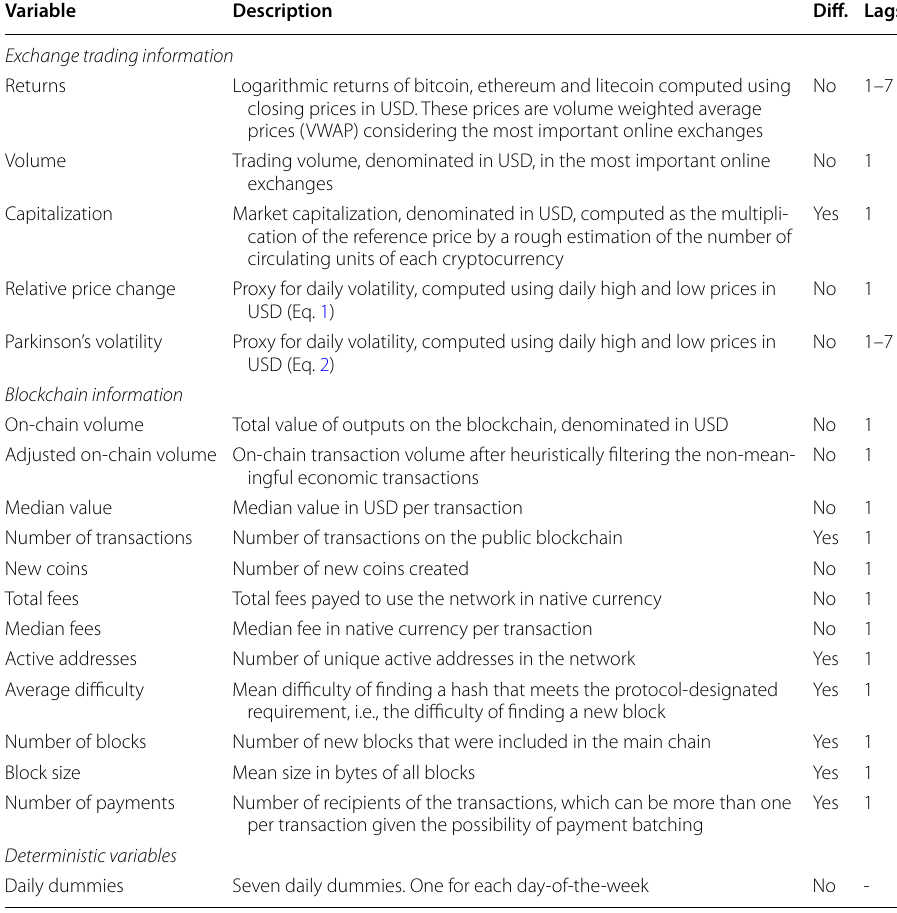
This table lists the input set for each cryptocurrency, composed of 50 variables: 31 obtained from exchange trading information, 12 obtained from blockchain information, and 7 day-of-the-week dummies. All these variables have a daily frequency time-stamped at 00:00:00 UTC of the next day. The column “Diff” indicates if the variable was used in levels or was